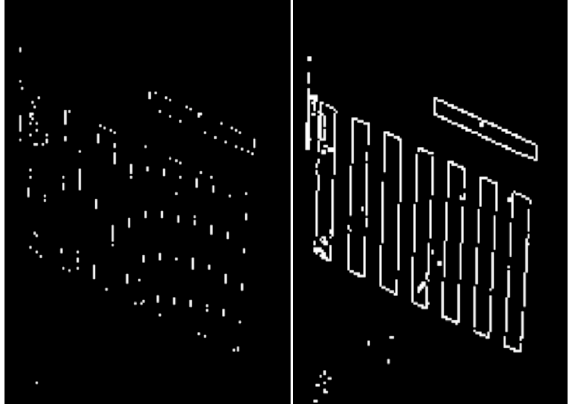
Figure 7. Edge detection of the zebra crossing (left). Image after a dilation